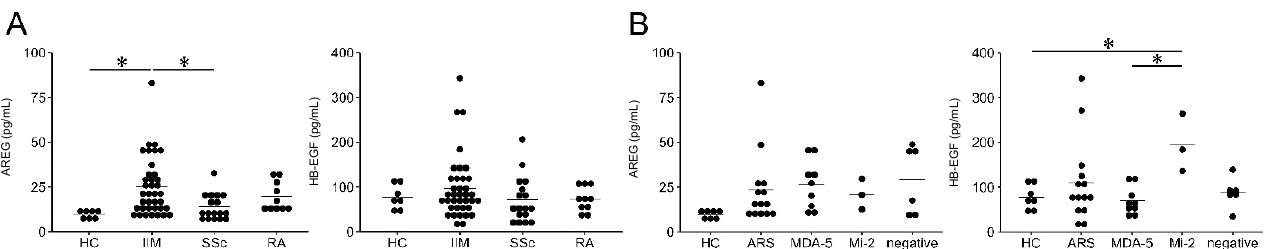
Figure 1. Serum levels of AREG and HB-EGF in HC and patients with IIM. ( A ) Serum levels of AREG (left) and HB-EGF (right) in HC and patients with IIM, SSc, and RA. ( B ) Serum levels of AREG (left) and HB-EGF (right) in HC, patients with anti-ARS, anti-MDA-5, and anti-Mi-2 antibodies, and patients who were antibody-negative. Groups with ≥ 3 patients were analyzed. HC: healthy controls; IIM: idiopathic inflammatory myopathy; SSc: systemic sclerosis; RA: rheumatoid arthritis; ARS: aminoacyl-tRNA synthetase; MDA5: melanoma differentiation-associated gene 5 protein; AREG: amphiregulin; HB-EGF: heparin-binding epidermal growth factor. Differences were analyzed by 1-way ANOVA followed by Tukey’s multiple comparison test: * p < 0.05.